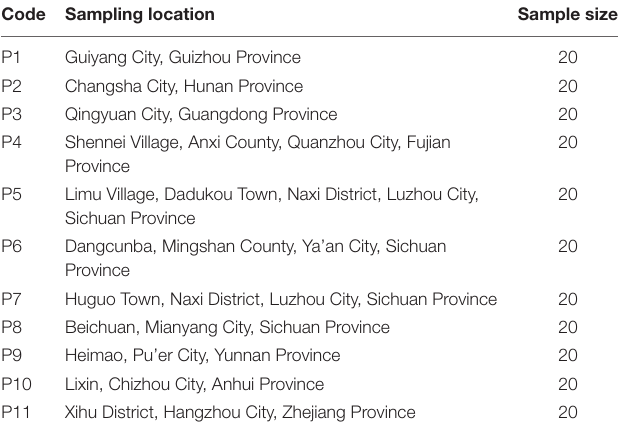
TABLE 1 | Sample information in this study. Code Sampling location Sample size